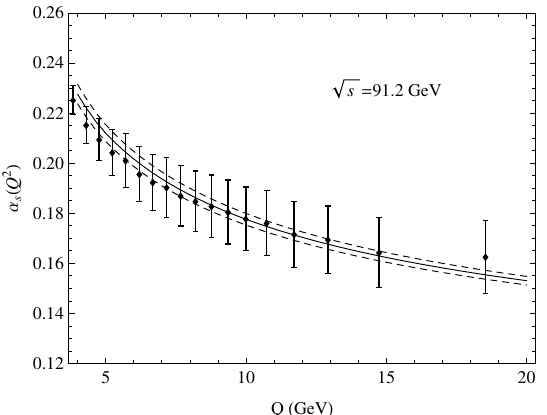
Figure 15. Similar to figure 12, but α s ( Q 2 ) extracted from the total jet broadening ( B T ) distribu- tion.